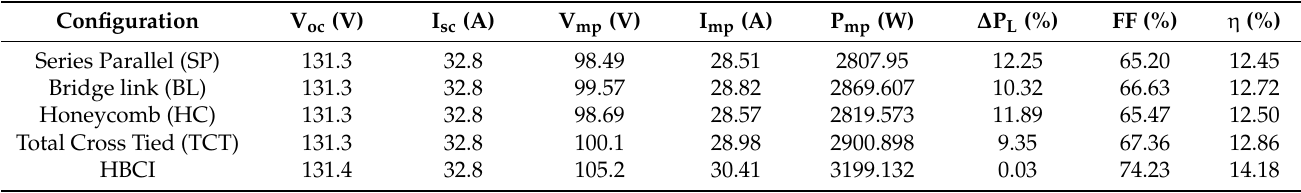
Table 2. Case 1: single-panel